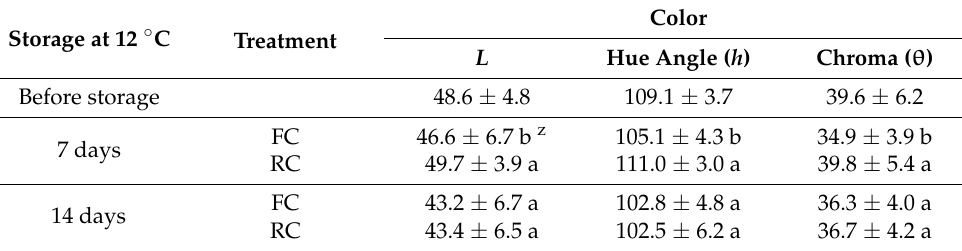
Table 2. Effects of FC and RC on changes in pod color during the storage of winged bean pods.